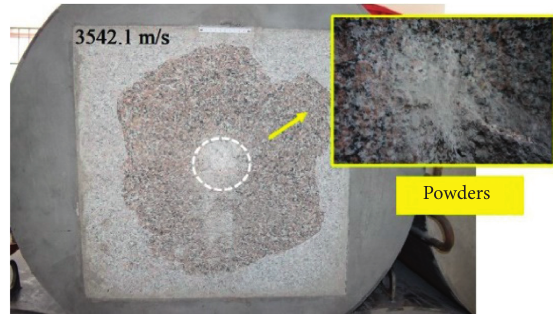
Figure 4: Crushing area at the bottom of the crater.